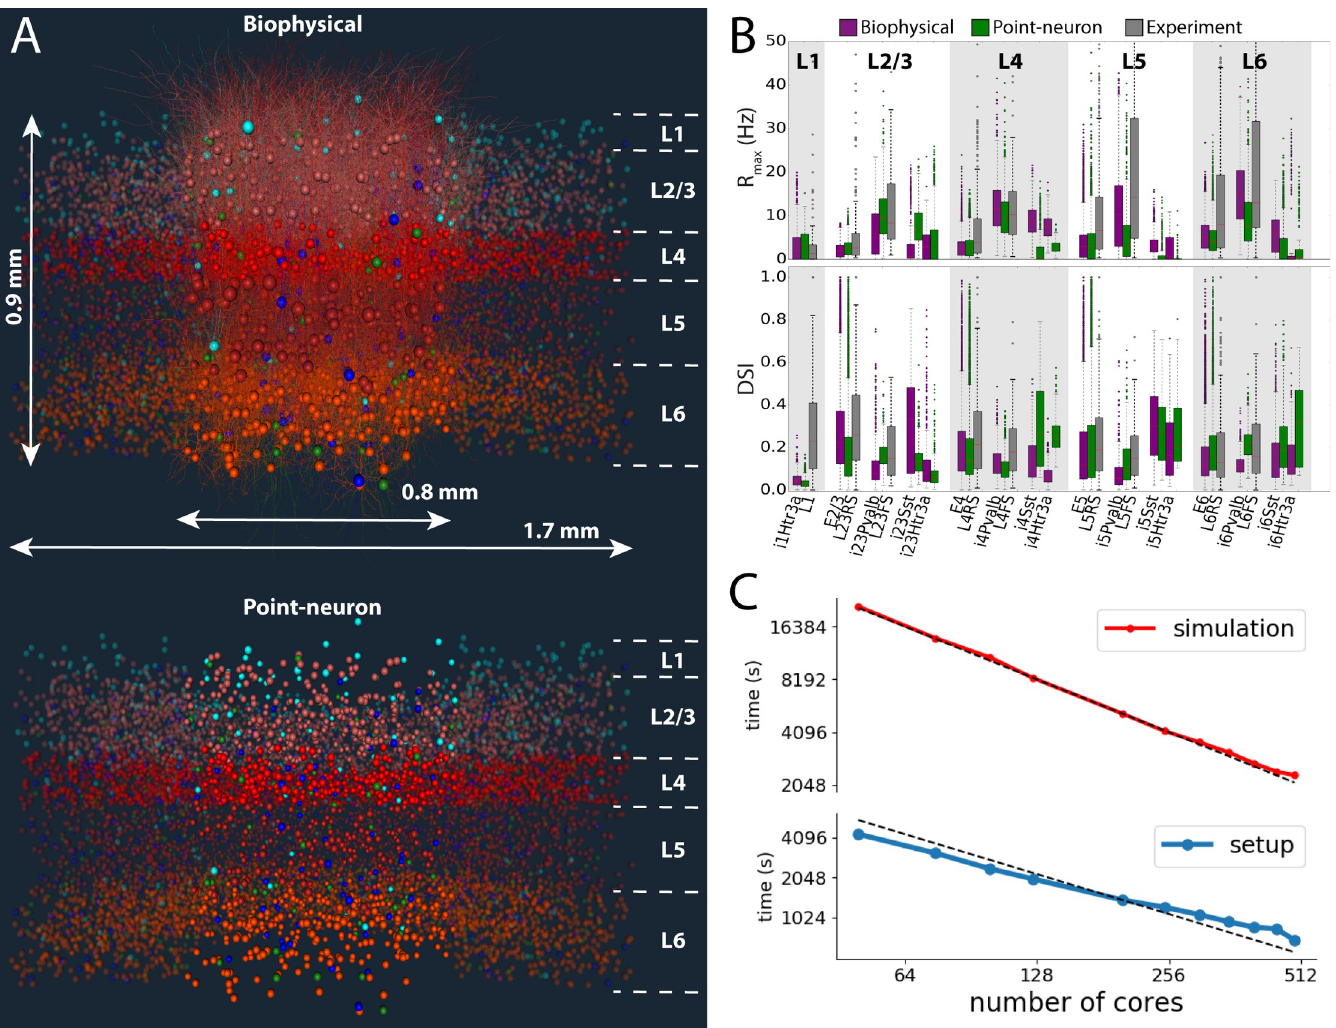
Fig 6. The biophysical and point-neuron V1 models. (A) Visualizations of the biophysical and point-neuron models. The 230,000-neuron models emulate the central portion of the mouse V1, across the full cortical depth, containing layers 1, 2/3, 4, 5, and 6 (layer boundaries are indicated). In the top model, the core portion, ~50,000 neurons, is simulated using biophysically detailed compartmental neuronal models, and the annulus around the core using leaky integrate-and-fire (LIF) point-neuron models. In the bottom model, both core and the annulus employ the generalized LIF neuronal models. Neurons are colored by cell class: hues of red for excitatory cells in layers 2/3, 4, 5, and 6, and blue, cyan and green for Parvalbumin- (Pvalb), Somatostatin- (SST), and 5-hydroxytryptamine receptor 3A- (Htr3a) expressing inhibitory cells classes. (B) Summary of firing rates and direction selectivity index (DSI) obtained from the biophysical and point-neuron simulations, vs. experimental extracellular electrophysiology recordings, by cell class. The data were obtained from 2.5-second long presentations of drifting gratings at 8 different directions, 10 trials each. “RS” and “FS” are experimentally determined regular- and fast-spiking cells, roughly corresponding to excitatory and Pvalb inhibitory neurons; the SST and Htr3a neurons could not be identified from experiments. (C) Performance benchmarks and scaling of simulations and setup (including disk I/O) of the biophysical version of the V1 model using BMTK’s BioNet. The simulation involved 0.5 s presentation of gray screen and 2.5 s of a drifting grating. The time shown is the wallclock time it took to obtain 1 second of simulated time, averaged over 3 s of simulation. The dashed lines indicate ideal scaling (relative to 125 cores, which is a typical choice for simulation of such scale).